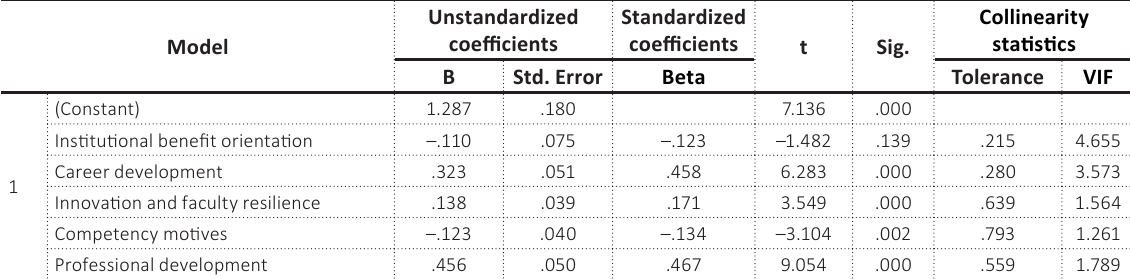
Table 7. Impact of faculty development program on faculty motivation: Indirect effect